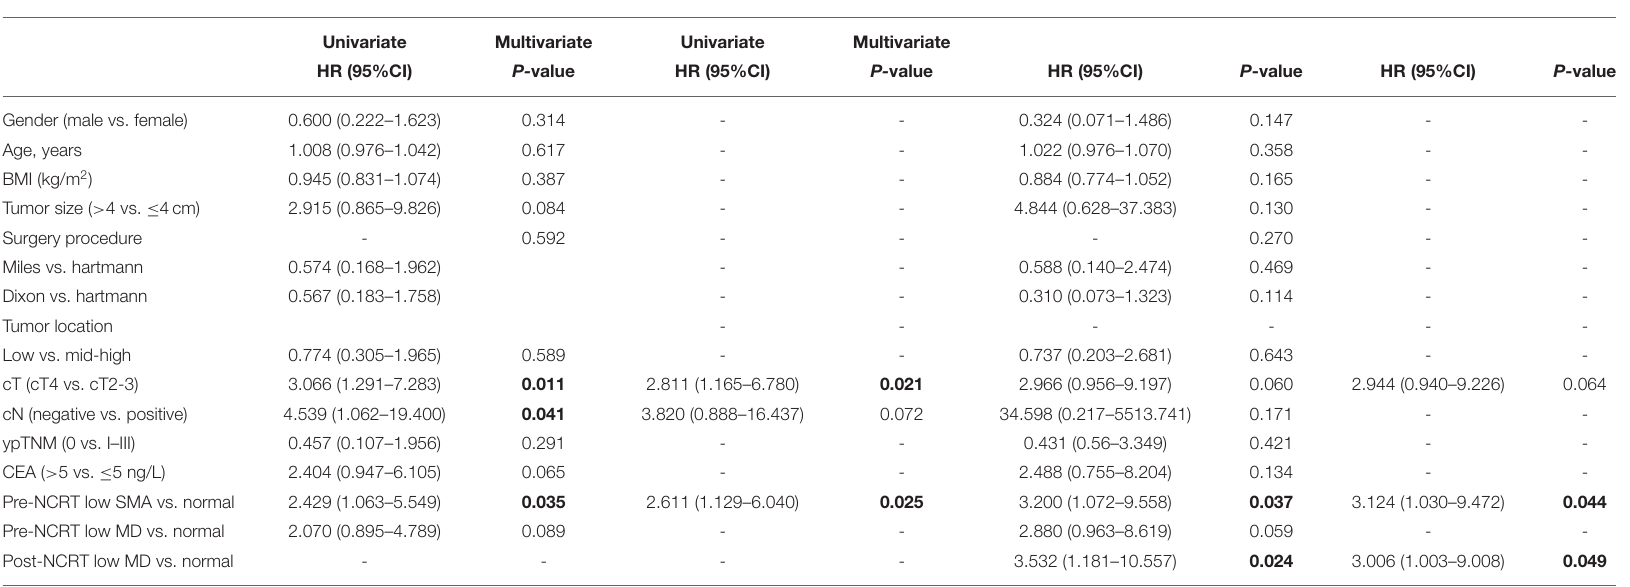
TABLE 2 | Cox proportion independent predictors of DFS and CCS in LARC